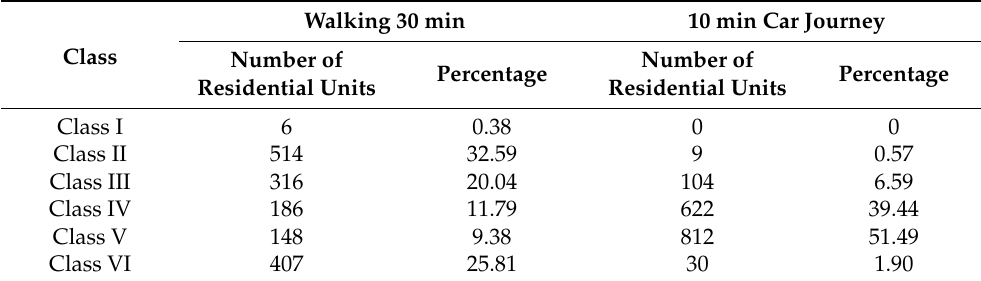
Figure 5. Residential district equity values. ( a ) Equity values for residential districts within a 30 min walk; ( b ) equity values for residential districts with a 10 min car journey. Table 4. Supply classification statistics for residential units with walking 30 min and driving 10 min by car.